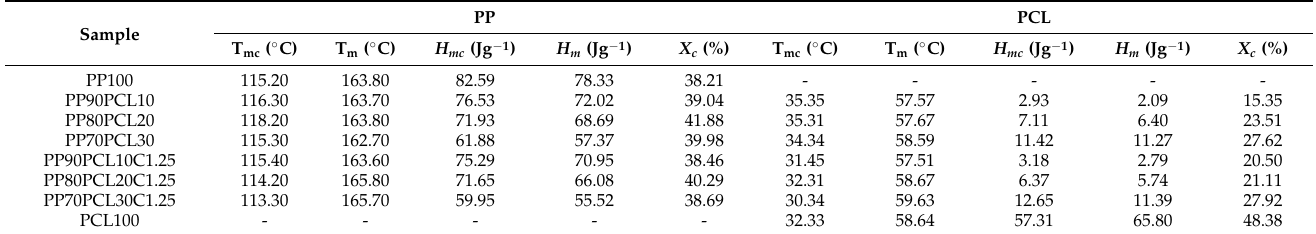
Table 2. Thermal parameters of PP, PCL, PP/PCL, and PP/PCL/PP-g-ma [30].